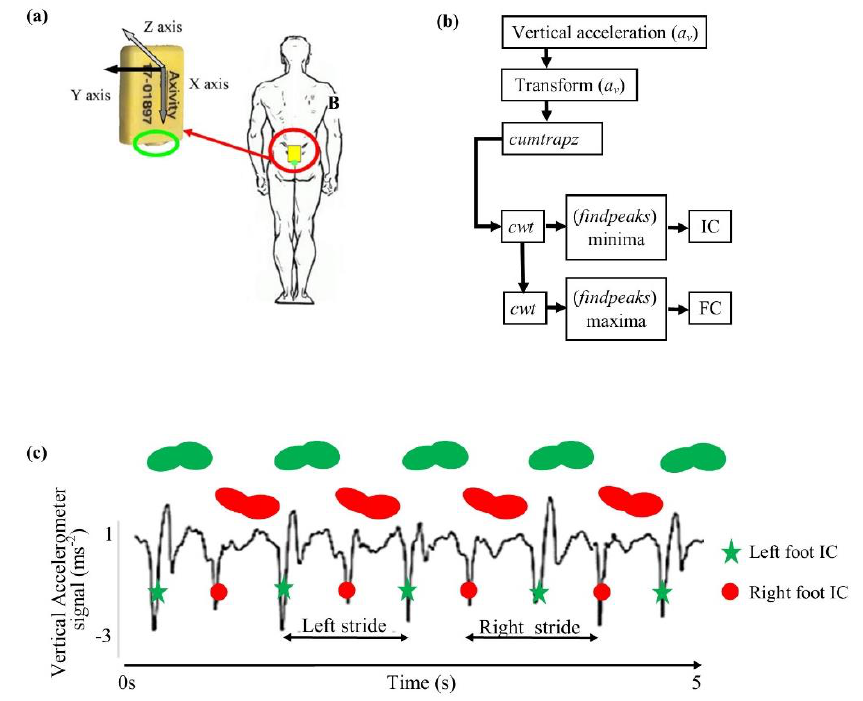
Figure 1. ( a ) Experimental setup: The site of attachment and orientation of the tri-axial accelerometer device on the lower back (L5). In dark grey x (vertical) axis, in black y (mediolateral) axis, and in light grey z (anteroposterior) axis. ( b ) Flowchart of analysis to determine gait events using MATLAB functions cumtrapz , cwt, and findpeaks . IC: Initial contact; FC: Final contact. ( c ) Vertical component of accelerometer signal with gait events and stride cycles indicated.